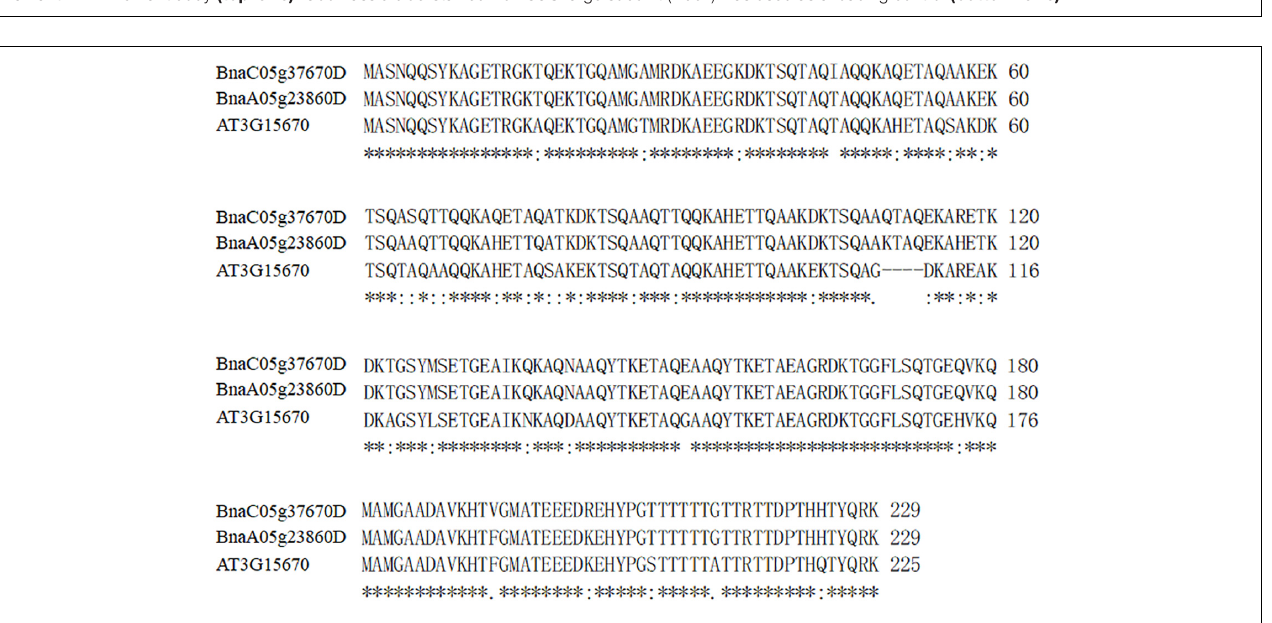
FIGURE 4 | Protein abundance of BnLEA57 in different seed development stages and in different lines (HOCL and LOCL). Seed protein samples were probed with an anti-BnLEA57 antibody (top lane) . Coomassie blue-stained RuBisCO large subunit (RbcL) was used as a loading control (bottom lane) .